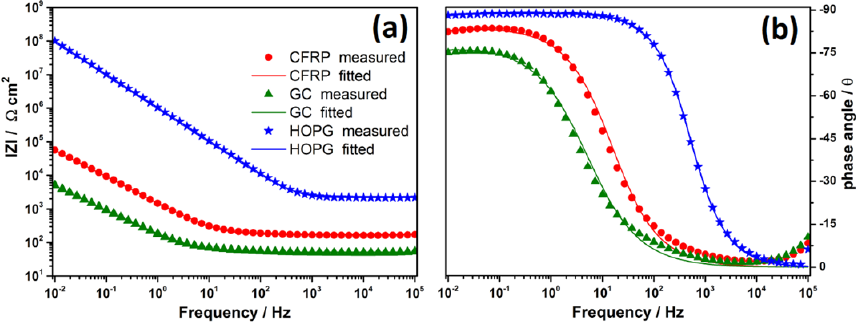
Figure 5. Bode plots of CFRP, HOPG, and glassy carbon in 50 mM NaCl adjusted to pH 7 after 1-h immersion at OCP presented as ( a ) IZI and ( b ) phase angle plots (inset in Figure 4c is the equivalent circuit used to fit the spectra).